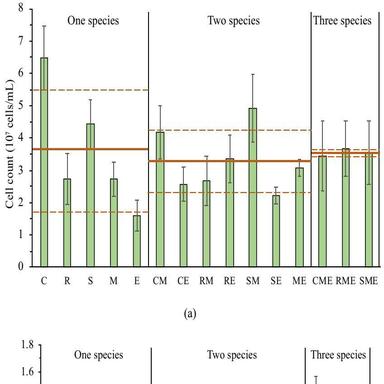
Average values of the total cell count (a) and MLSS (b) for different cultures after Day 20 (n = 15), with error bars displaying the corresponding standard deviations; The bold solid and dash lines in orange represent the average cell count and standard deviations for different groups of cultures containing one, two and three species, respectively.